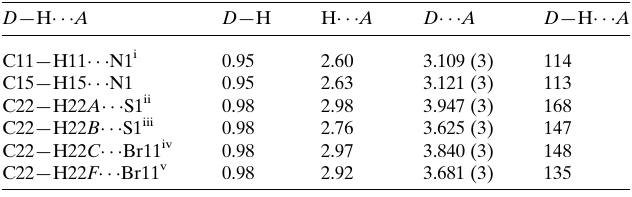
Table 2 Hydrogen-bond geometry (A˚ , (cid:4) ).